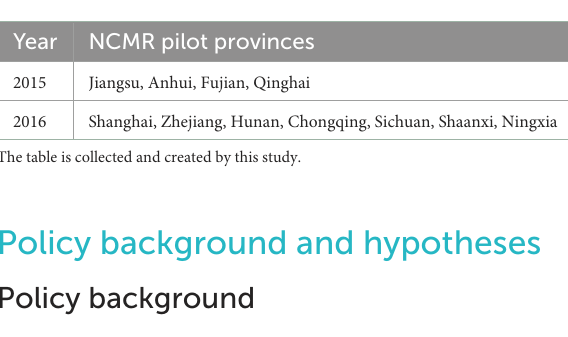
TABLE 1 China’s NCMR pilot